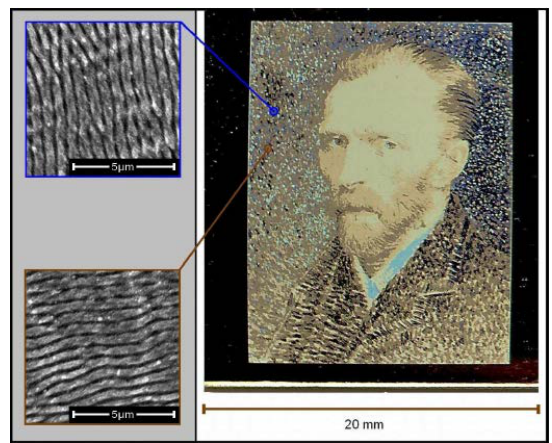
Figure 3: (a) Color printing on a stainless steel surface by nanorip- ple formation using a femtosecond laser. The image was obtained using a typical reading scanner. (b) SEM images of controlled nanostructures with different orientations created at different po- sitions and showing different colors [32]. Reproduced with per- mission from The Optical Society of America, © 2010 by The Optical Society of America.